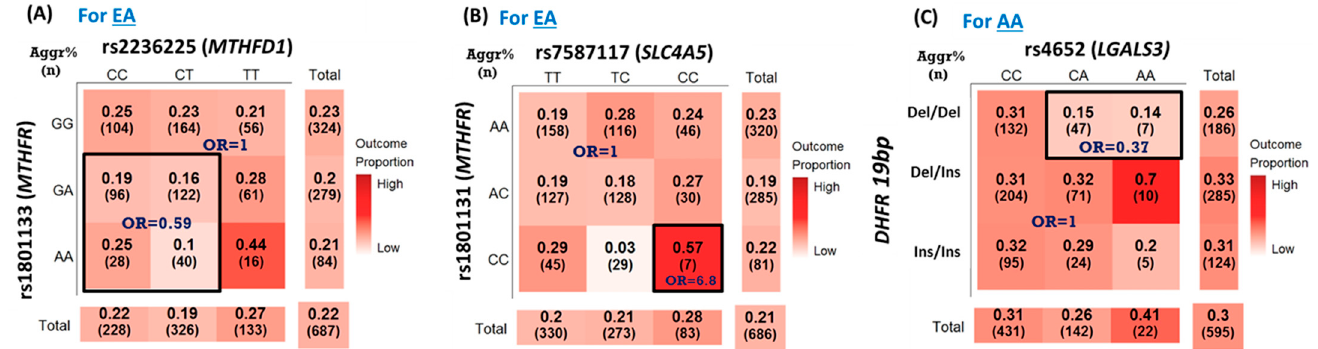
Figure 2. Three selected SNP–SNP interactions associated with prostate cancer aggressiveness. ( A ) rs1801133 ( MTHFR )-rs2236225 ( MTHFD1 ) in European Americans (EAs) with the DR_int_or inter- action pattern, OR = 0.59 (95% confidence interval [CI] = 0.40–0.88), p = 0.009. ( B ) rs1801131 ( MTHFR )— rs7587117 ( SLC4A5 ) in EAs with the RR_int_oo interaction pattern, OR = 6.8 (95% CI = 1.39, 33.28), p = 0.018. ( C ) interaction of DHFR -19 bp polymorphism and rs4652 ( LGALS3 ) in African Americans (AAs) with the DD_int_ro interaction pattern, OR = 0.37 (95% CI = 0.17–0.81), p = 0.012. Note: In each cell, the first value is the prevalence of prostate cancer aggressiveness, and the 2nd value in parenthesis is the sample size in each genotype combination. Table 4. SNP–SNP interactions associated with prostate cancer aggressiveness in European Ameri- cans.